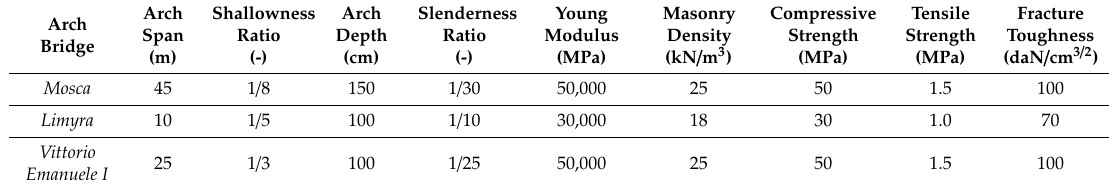
Table 1. Geometrical and mechanical parameters of the analyzed arch bridges.